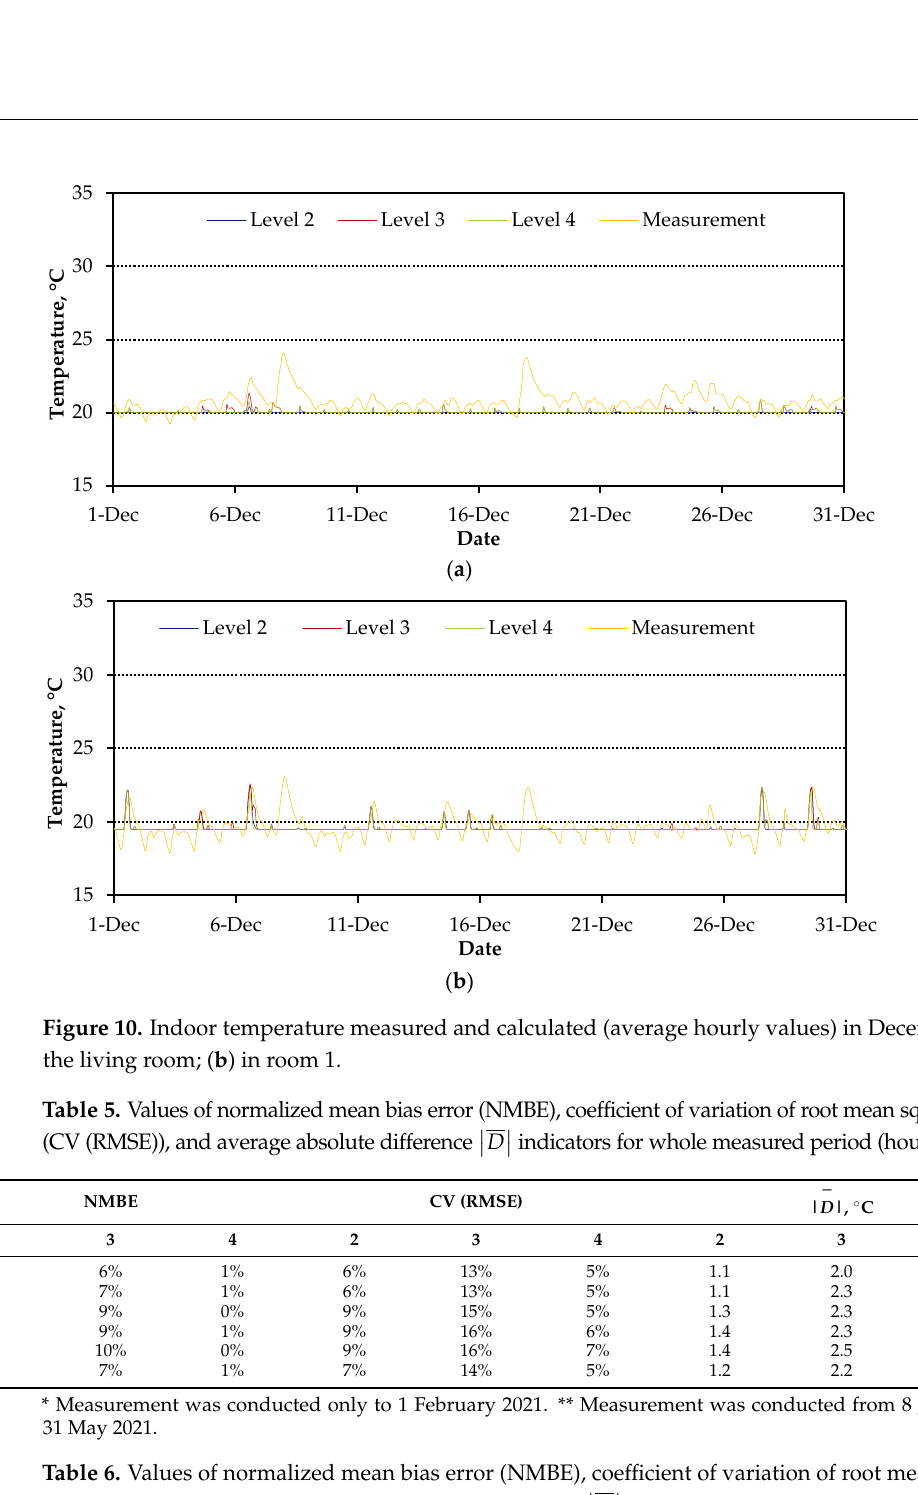
(cid:12) (cid:12) (cid:12) D (cid:12) ) indicators for whole measured period